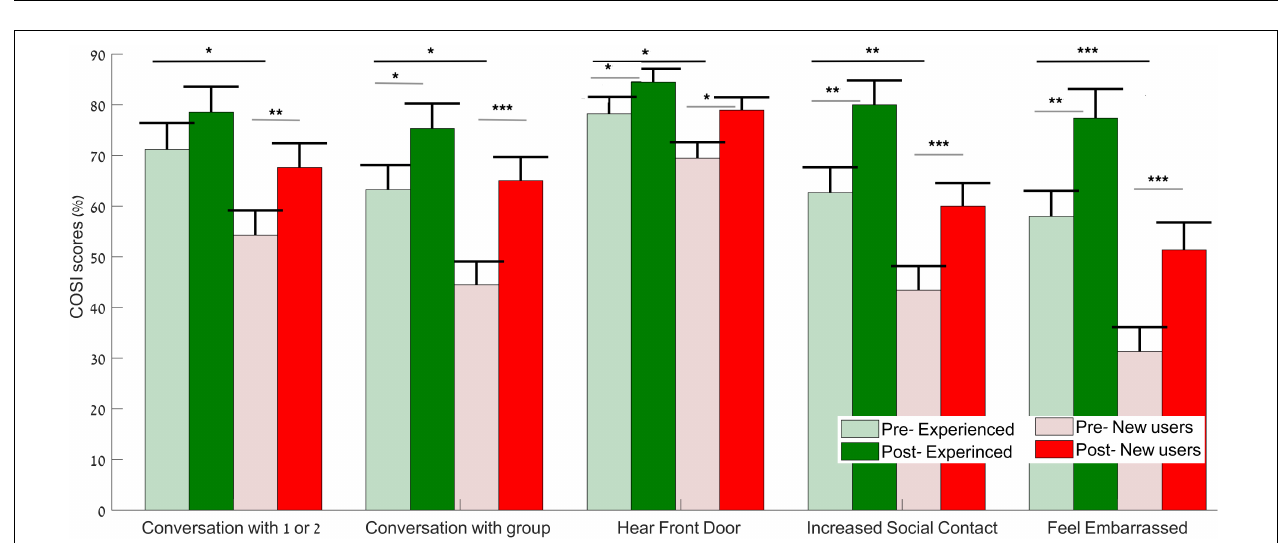
FIGURE 3 | Hearing Handicap Inventory for elderly (HHIE) mean score for the experienced (green), new users (red) and non-users (black) obtained from the pre- and post- reports across the social-situational questions (A) , and the emotional questions (B) . Error bars represent standard error of the mean. Lines indicate between group comparisons (black lines) and within group (gray lines) comparisons, * p < 0.05, ** p < 0.01, *** p < 0.001.